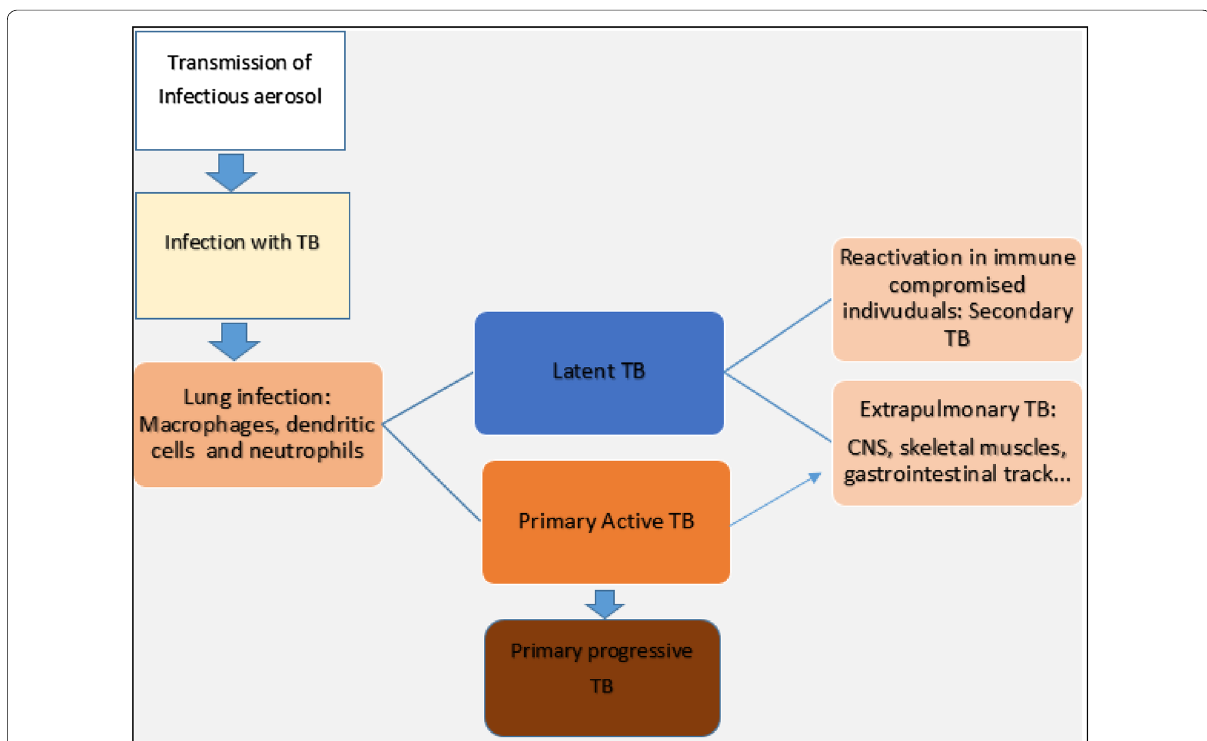
Fig. 1 Tuberculosis infection and development: after the transmission with infectious aerosol, the M.tb bacilli infect the lung macrophages, dendritic cells and neutrophils. The infection may result in active or latent. The latent and active infection can be spread to extrapulmonary organs. The reactivation of latent infection results in secondary